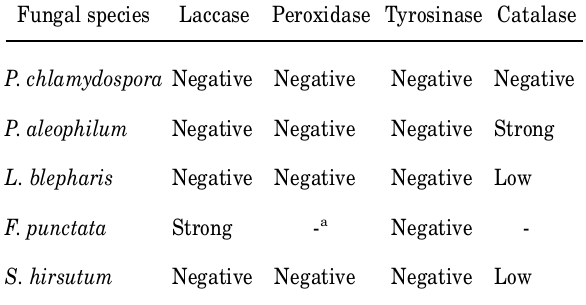
Table 5. Phenol oxidase